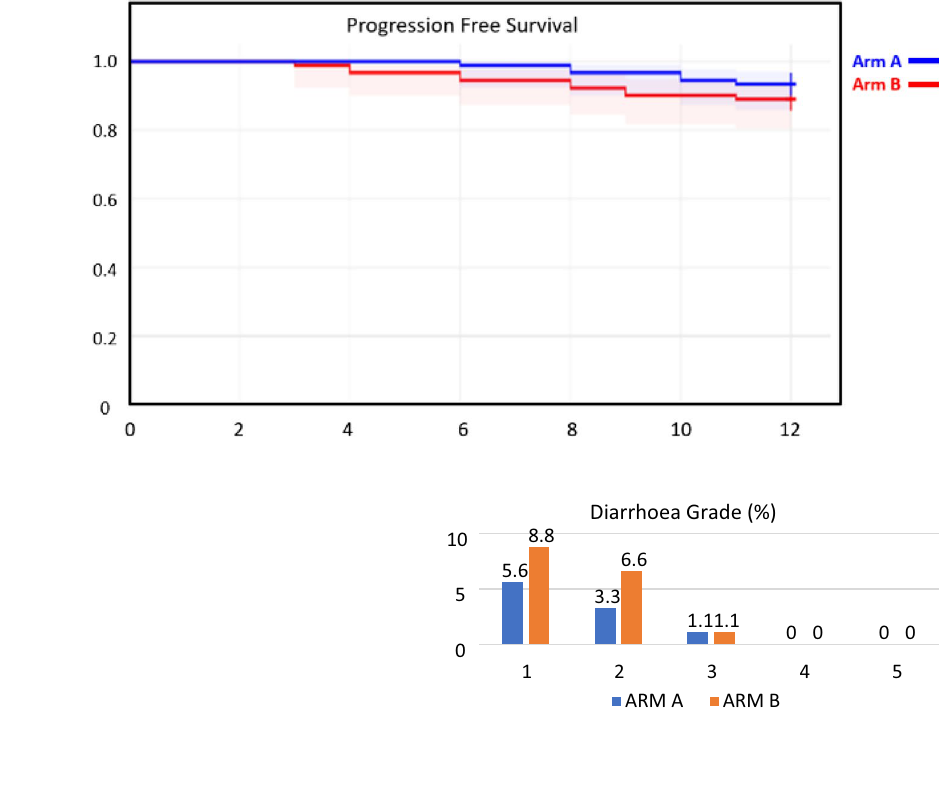
Fig. 3 Progression Free Sur- vival in both the arms